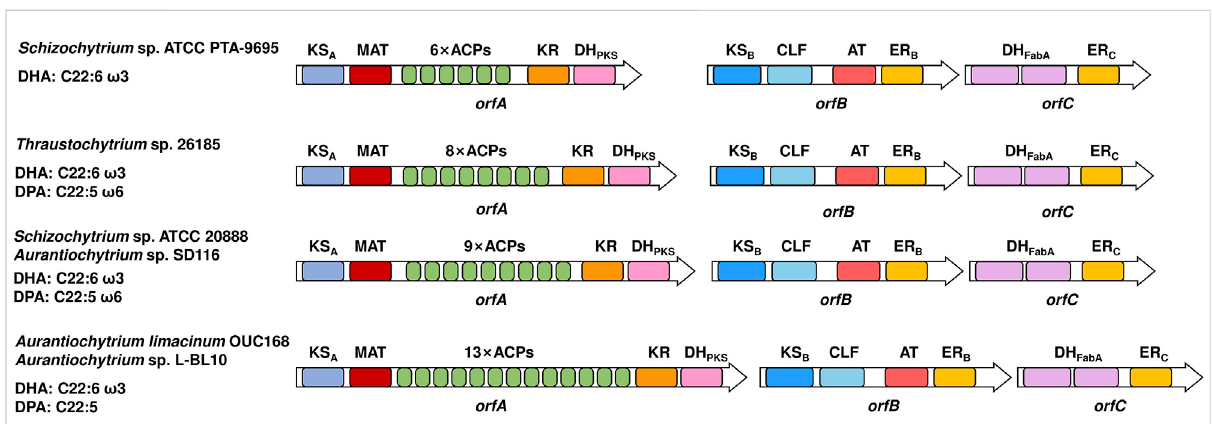
FIGURE 1 DomainorganizationsofeukaryoticPUFAsynthases.OntheleftarethenativesourcesandmainproductsofPUFAsynthases.Differentdomains are indicated by colors. ACP, acyl carrier protein domain; MAT, malonyl-CoA: ACP transacylase domain; KS, ketoacyl-ACP synthase domain; CLF, chain length factor domain; KR, ketoacyl-ACP reductase domain; DH PKS , PKS-like dehydratase domain; DH FabA , FabA-like dehydratase domain; ER, enoyl-ACP reductase domain; AT, acyltransferase domain. The subscripts A, B and C indicate that the corresponding domain is located in subunits A, B and C,